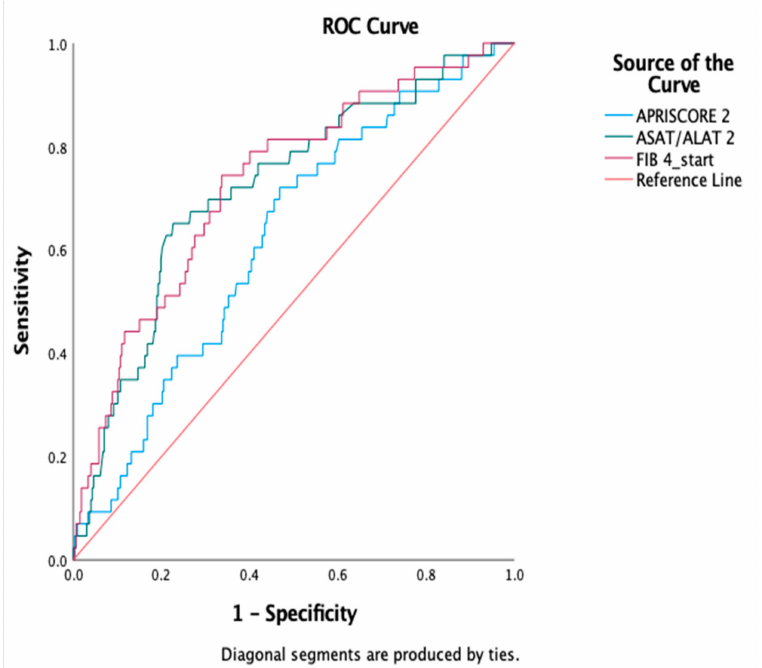
Figure 2. AUROC curves comparison for FIB-4, AST/ALT, APRI